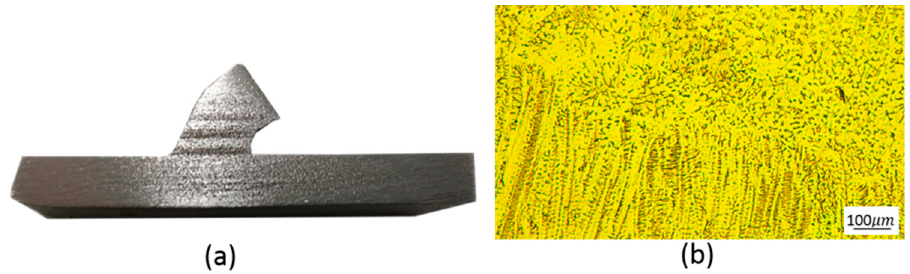
Figure 15. ( a ) Section of the connection between the rod and the lower panel; ( b ) Microstructure of the node.